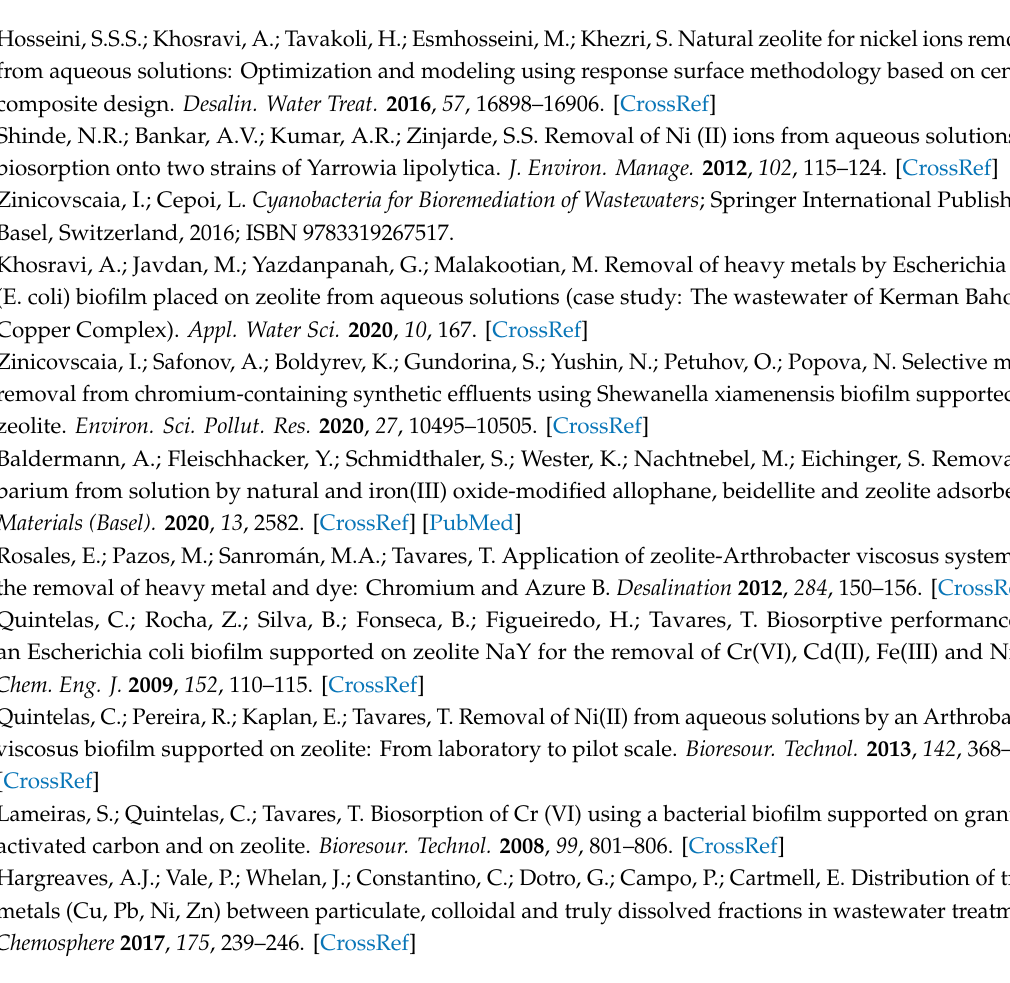
Figure S1: The thermodynamic speciation of Ni(II) ions in Ni(II) system as a function of pH, Figure S2: The thermodynamic speciation of metal ions in Ni(II)-Cr(III)-Fe(III) system as a function, Figure S3: The thermodynamic speciation of metal ions in Ni(II)-Cu(II)-Sr(II)-Zn(II) system as a function of pH, Figure S4: The thermodynamic speciation of metal ions in Ni(II)-Zn(II)-Mo(VI)-Cu(II) system as a function of pH, Figure S5: lnKd versus 1 /